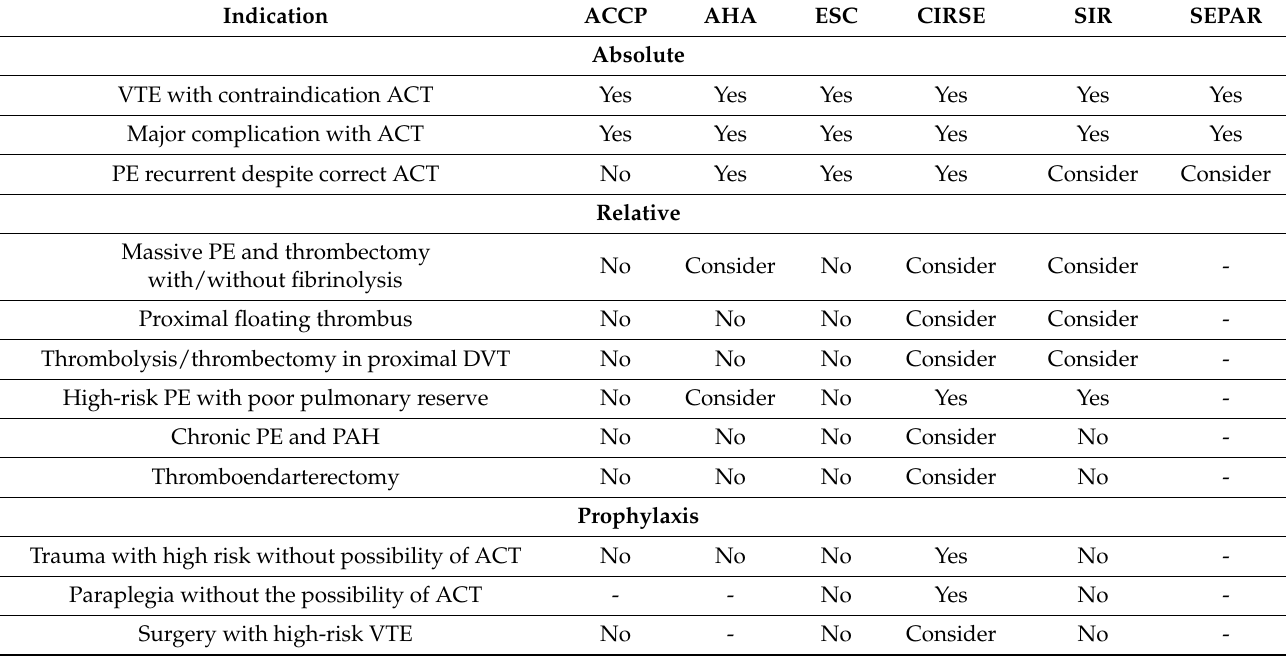
Table 2. Recommendations of the main clinical and radiology societies regarding IVCF [3–5,10,11,13]. The Implantation of temporary or retrievable Angel catheter-type IVCF should be performed